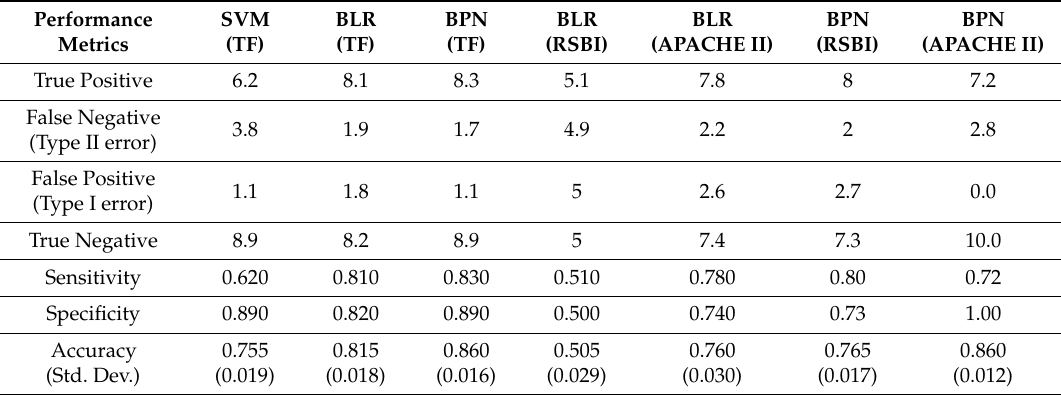
Table 3. A comparison of extubation prediction by di ff erent